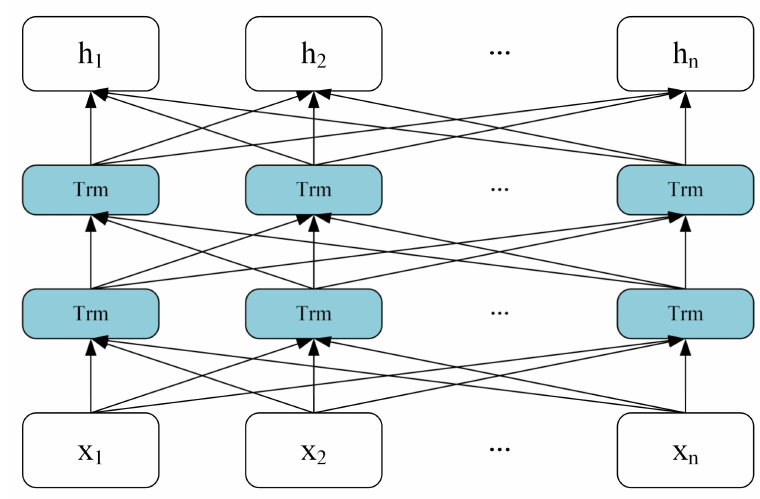
Figure 2. Network Structure of BERT Model.